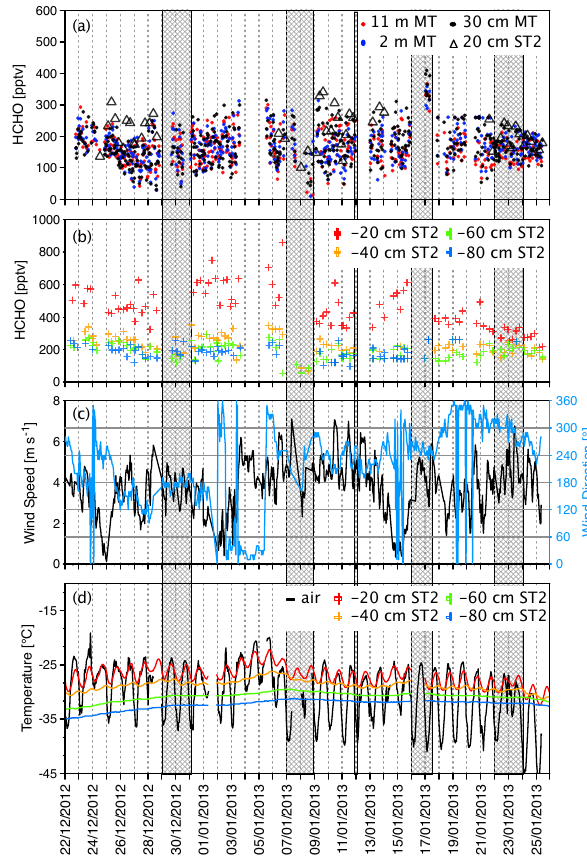
Figure 2. (a) Ten-minute averaged HCHO mixing ratios observed in the ambient air during the 2012/13 campaign at three different heights above the snow on the meteorological tower (MT) and at 20cm on snow tower 2 (ST2) (see Sect. 2.3). (b) Ten-minute aver- aged HCHO measured at different depths in the snowpack on ST2. (c) Wind speed and direction. (d) Temperature of air and in snow at different depths (ST2). Grey bands denote periods for which data were not considered due to technical problems with the analyzer and/or the snow tower system. They separate the six time intervals over which data were